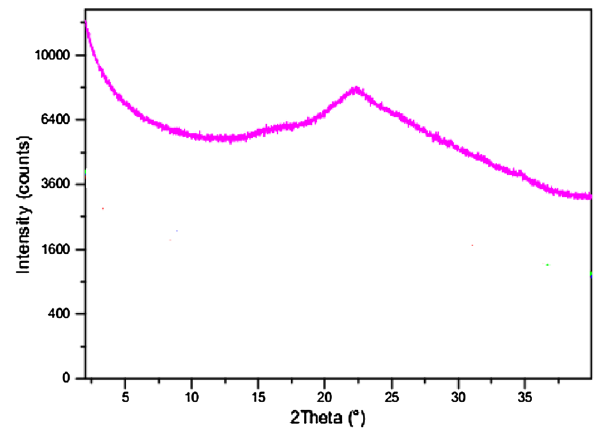
Fig. 3 XRD spectrum of C-ZMN adsorbent